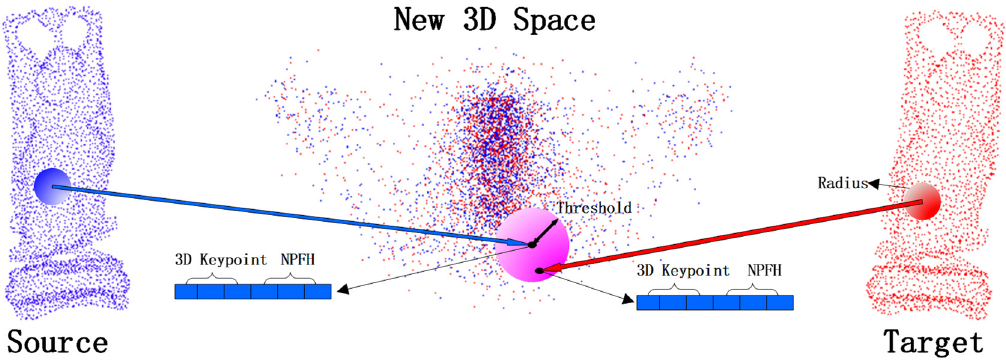
Figure 1. Schematic of 3DNPFH